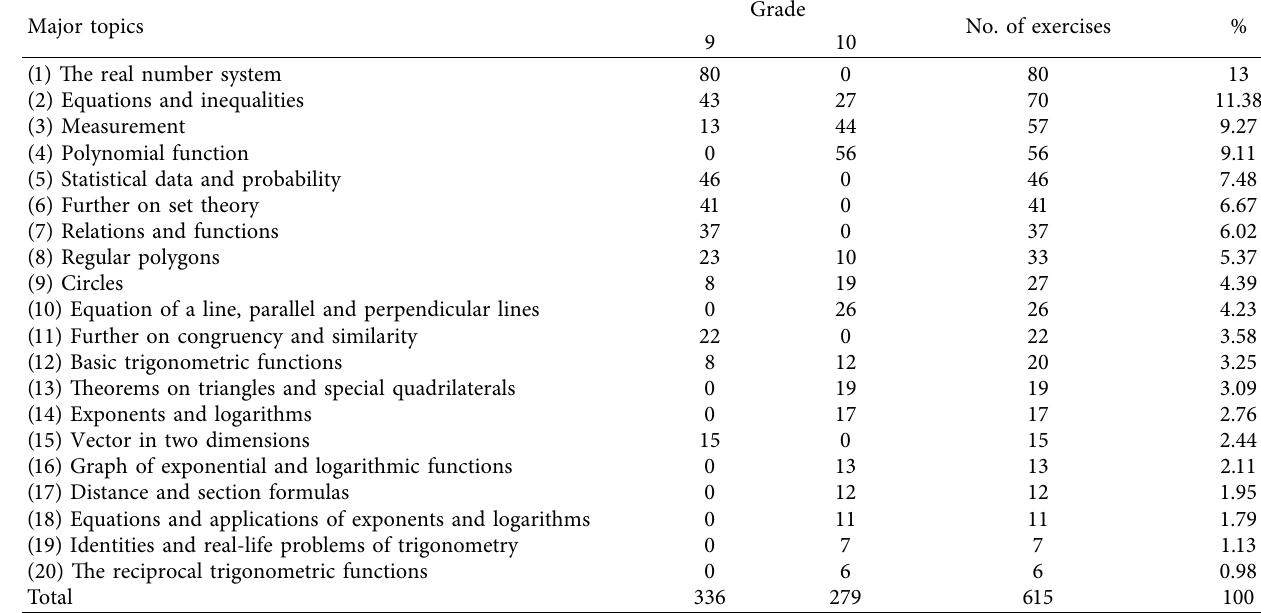
Table 3: Major topics and number of exercises in each major topic of grades 9 and 10 textbooks.